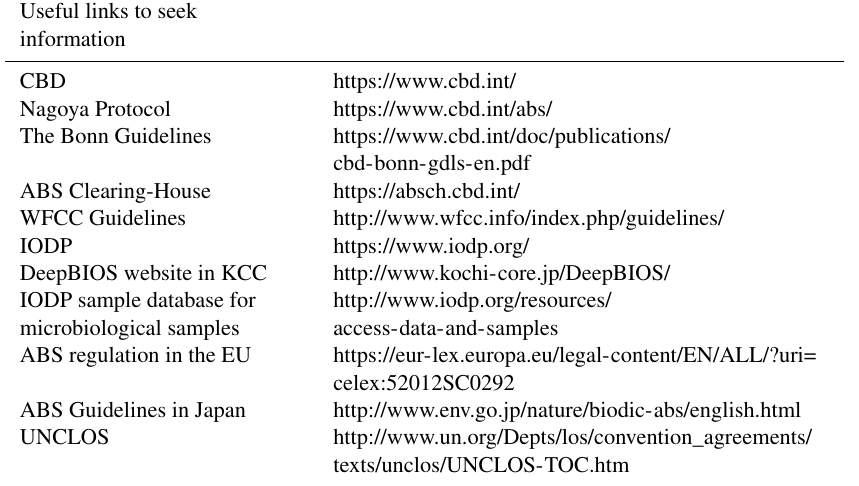
Table 1. Useful URL links are provided for scientists to seek detailed information. Abbreviations are listed in Appendix A. Useful links to